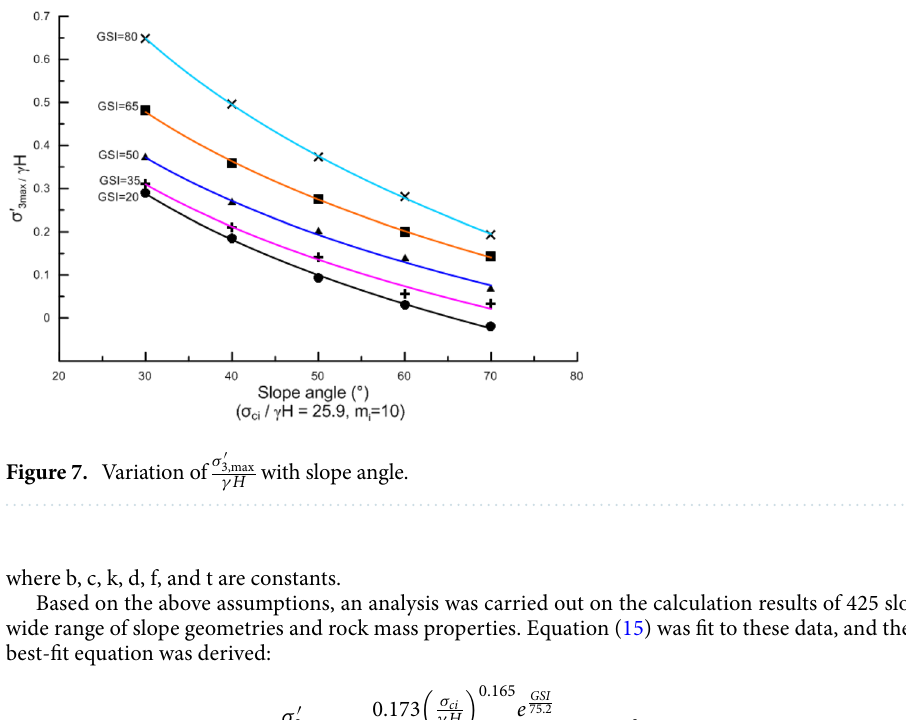
Figure 7. Variation of